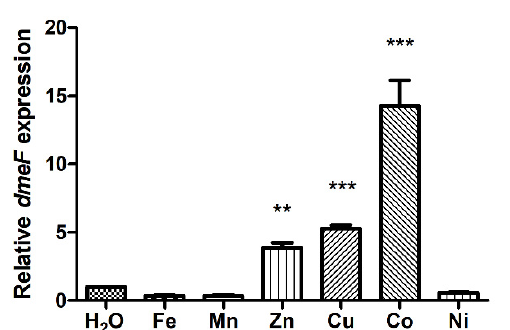
Figure 3. Induction of dmeF expression by various metals. V. parahaemolyticus RIMD 2,210,633 was incubated in H 2 O, 1 mM FeSO 4 , 1 mM MnSO 4 , 0.5 mM ZnSO 4 , 1 mM CuSO 4 , 0.25 mM CoSO 4 , or 1 mM NiSO 4 for 15 min. Expression of dmeF is reported relative to the H 2 O treatment. Results repre- sent the means and standard deviations (SD) from three biological replicates. The data were analyzed using one-way analysis of variance along with Bonferroni’s post-test. **, p < 0.01; ***, p < 0.001.